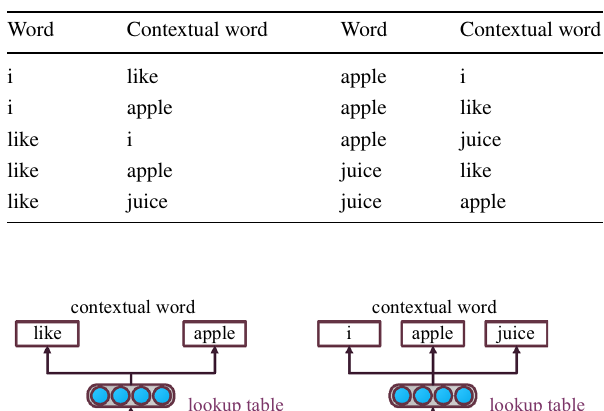
Table 1 Illustration of word–context pairs collection P for sentence “i like apple juice” (window size is 2)